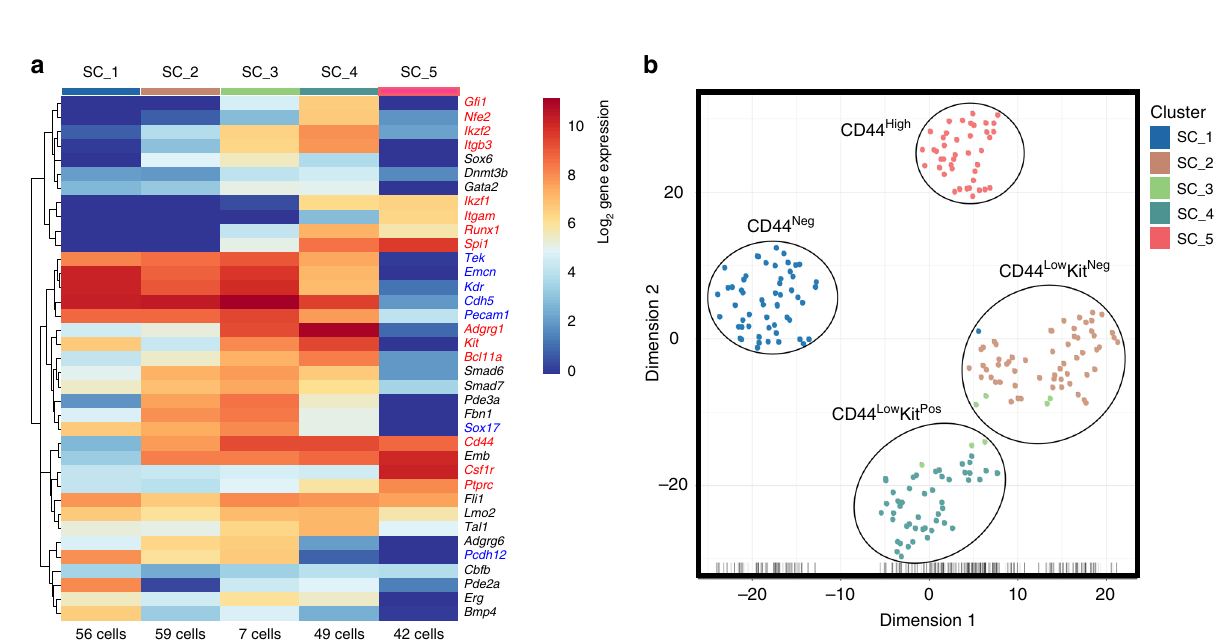
Fig. 3 The VE-Cad + subpopulations de fi ned by CD44 are transcriptionally distinct. a Heatmap showing average expression of endothelial (blue), haematopoietic (red) and various (black) genes in the indicated groups (genes are clustered using Pearson ’ s correlation). The number of cells for each cluster is indicated at the bottom of the panel. Five groups are indicated. b tSNE plot from single-cell q-RT-PCR data shown in a . See also Supplementary Fig. 3, Supplementary Fig. 4 and Supplementary Data